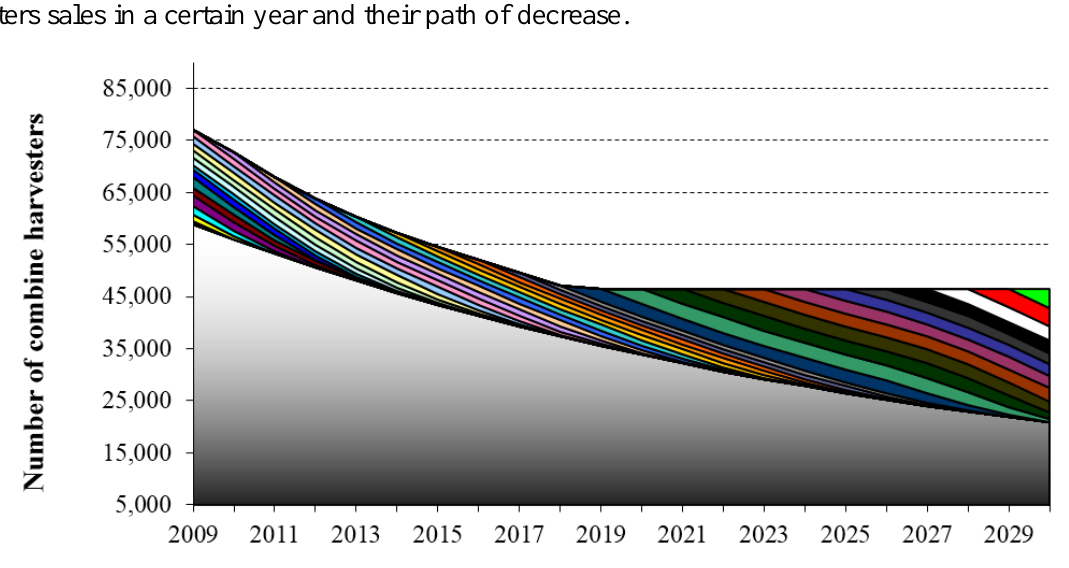
Figure 8. Inventory of combines cumulated from old stock and calculated domestic sales (2009–2030, colored lines). Source: Own calculations based on